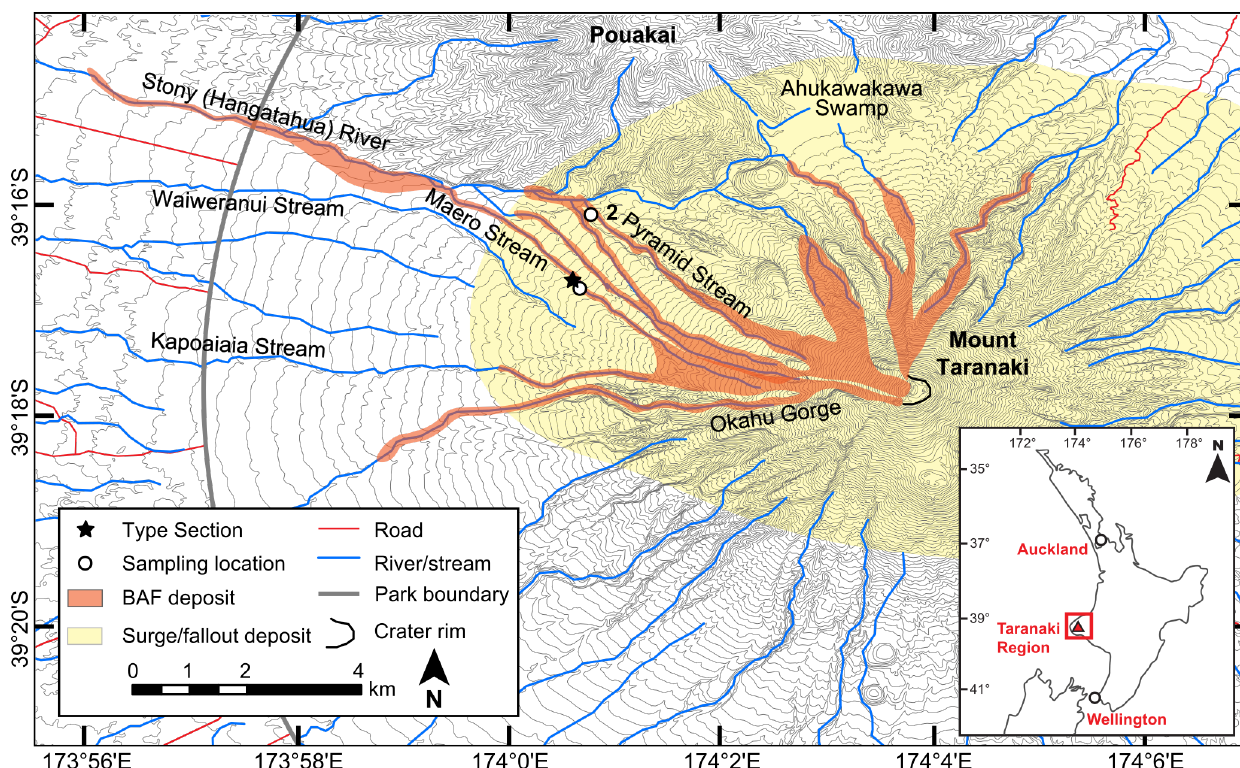
Figure 2: Map showing distribution of the Maero Formation—di ff erentiated into the BAF and surge/fall deposits—in the region surrounding Mt. Taranaki. Location of type section and supplemental sampling sites are also noted. Inset shows location of Taranaki on the North Island of New